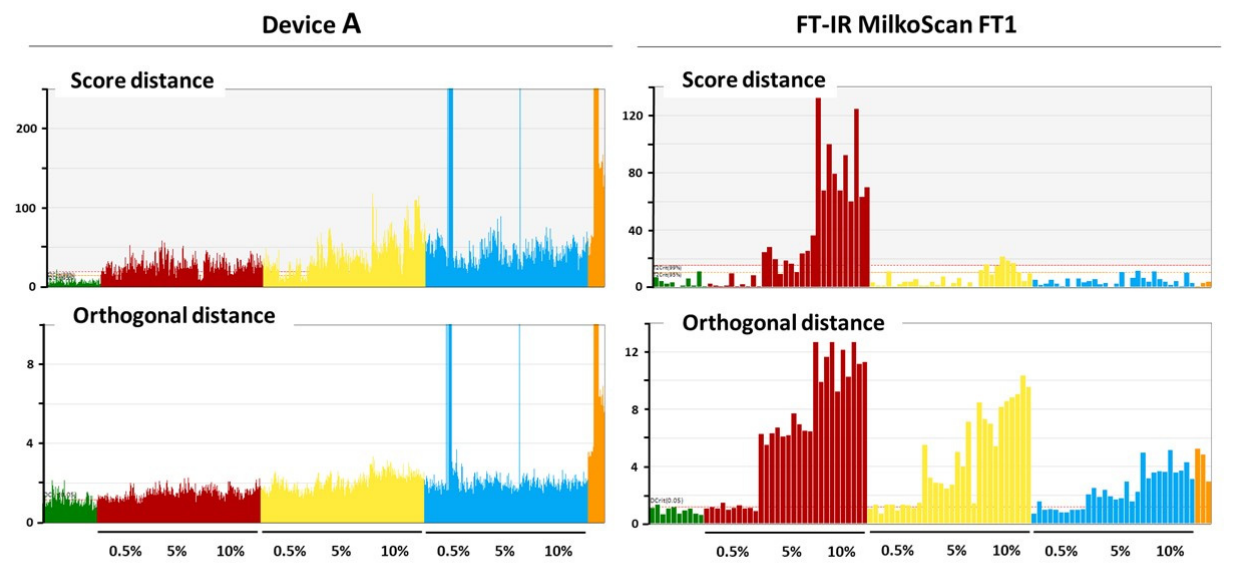
Figure 2. Score and orthogonal distances of control and adulterated dry-blended samples projected onto an OCC SIMCA model of NIR spectra acquired with either device A (left panel) or a FT-IR MilkoScan FT1 (right panel) on originally spray-dried skimmed milk powders. Color codes of samples: Green: control; Red: ammonium sulfate-adulterated; Yellow: cornstarch-adulterated; Blue: semicarbazide-adulterated; Orange: buffalo/cow mixtures.